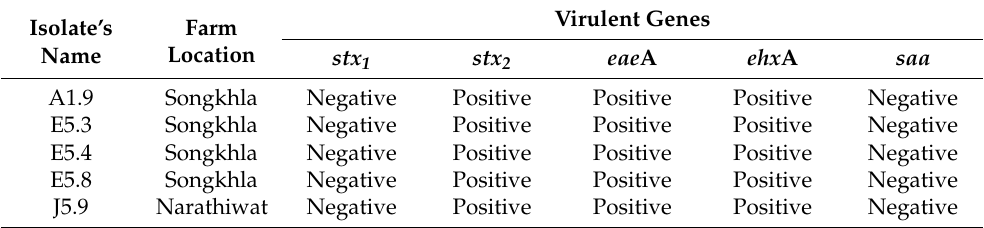
Table 3. Virulent genes profile of O157 isolates in